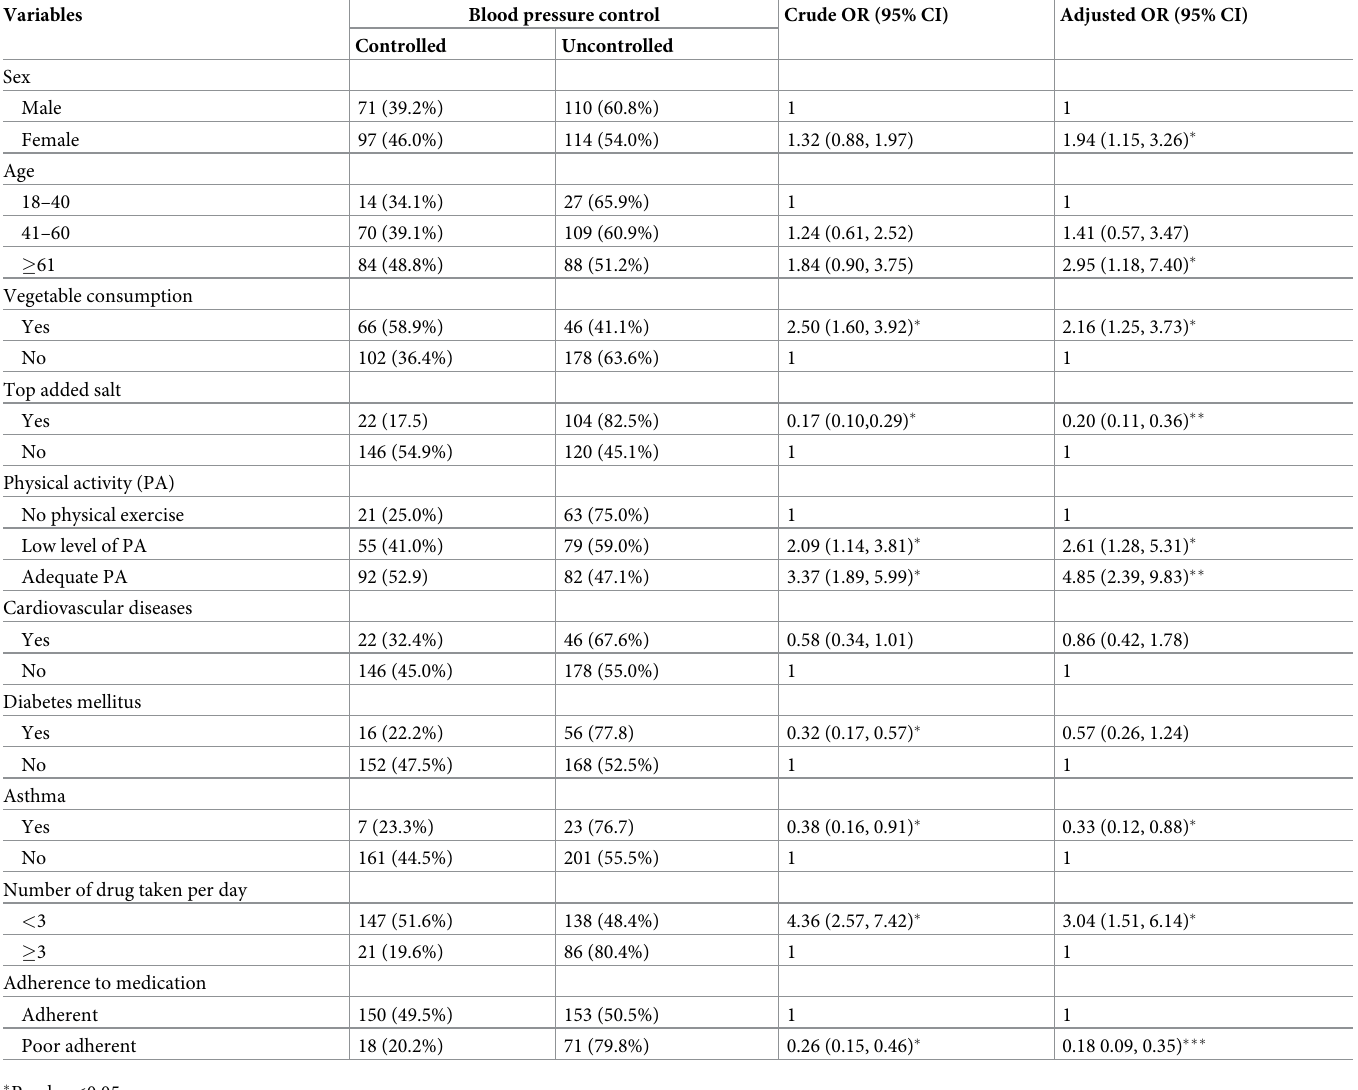
Table 3. Bivariate and multivariable logistic regression analysis of factors associated with optimal blood pressure control of hypertensive patients in Debre Tabor Hospital, ANRS, Northwest Ethiopia, May 2015 (n = 392).